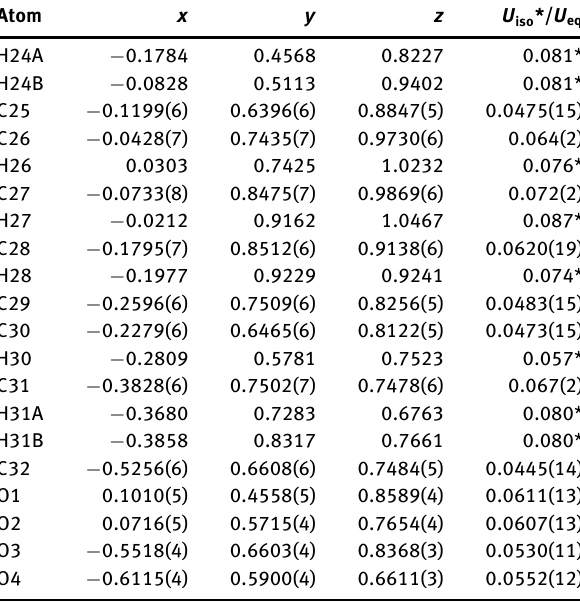
Table 2: Fractional atomic coordinates and isotropic or equivalent isotropic displacement parameters (Å 2